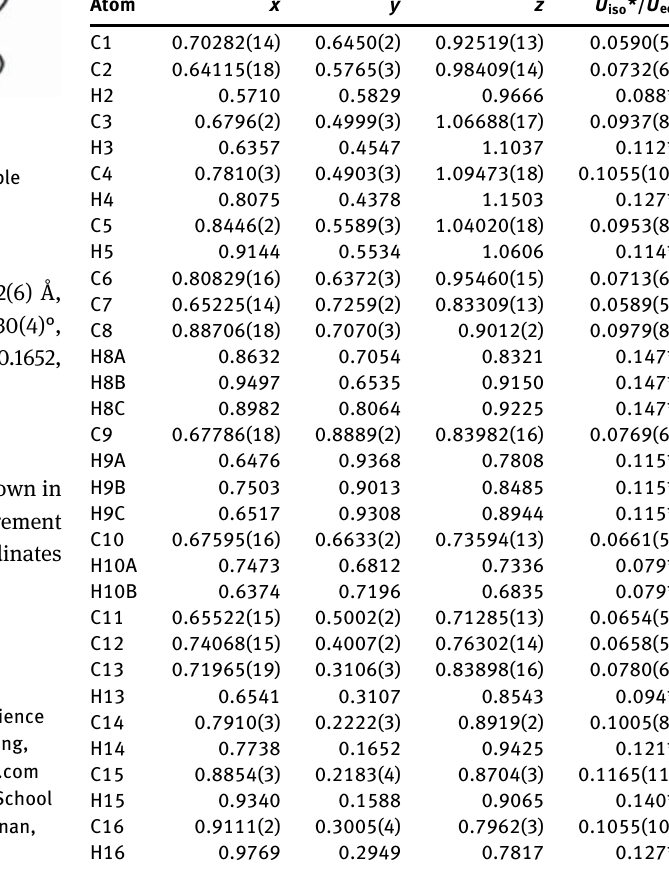
Table 2: Fractional atomic coordinates and isotropic or equivalent isotropic displacement parameters (Å 2